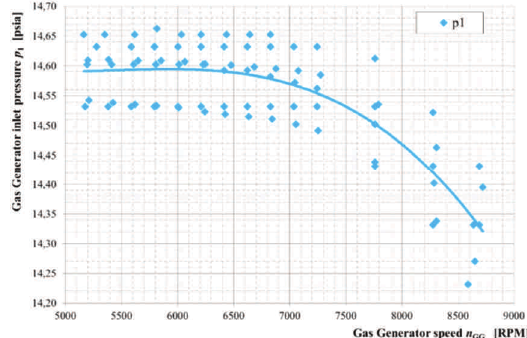
Fig. 7. Approximated function and the results of the measurements of gas generator inlet air pressure p 1 , recorded for steady-state operation of LM- 2500 engine, in relation to gas generator speed n GG